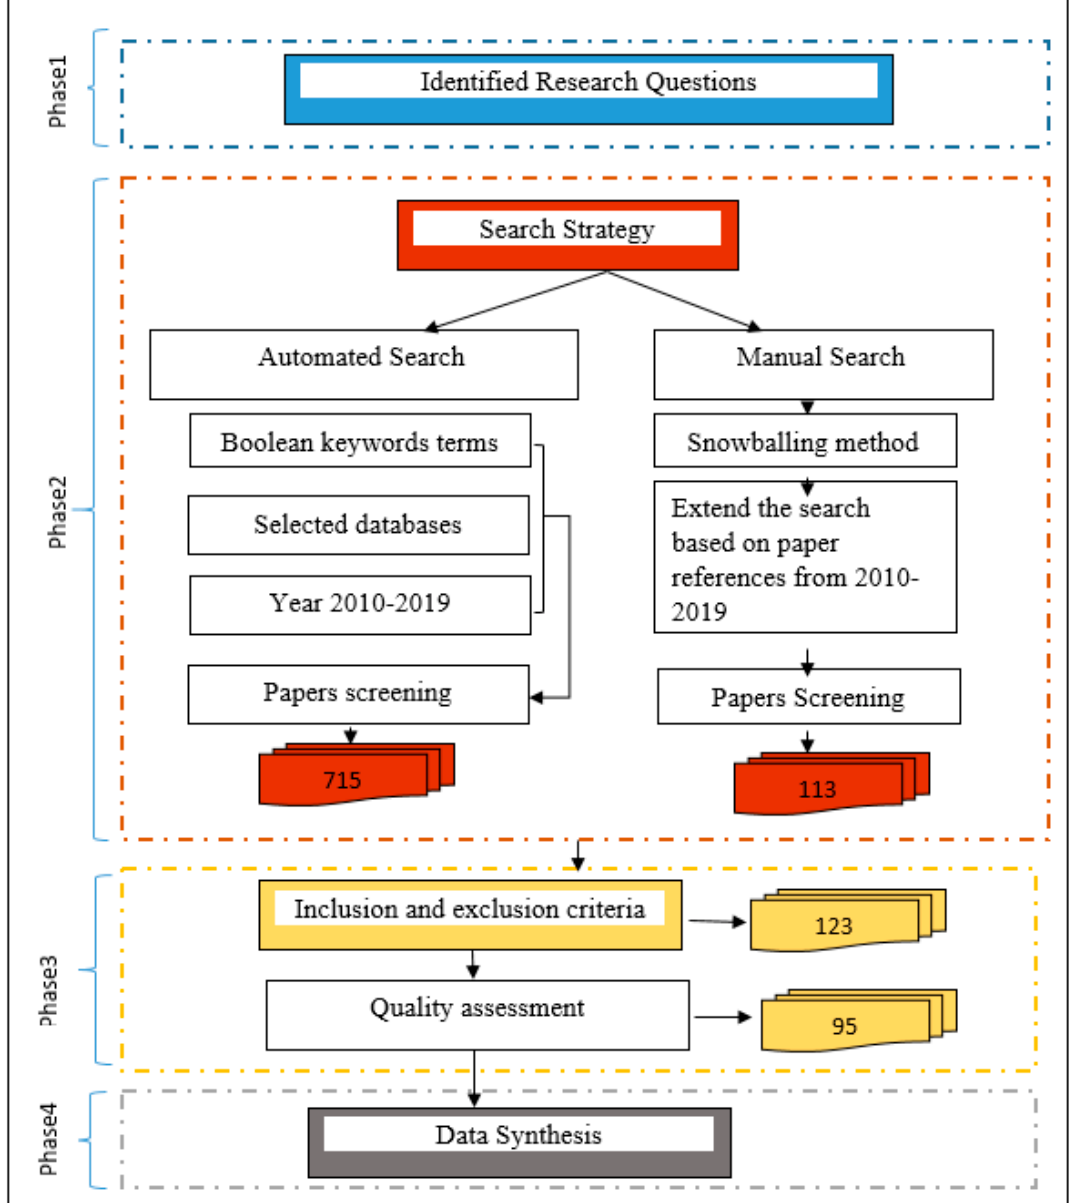
Figure 1. Research Figure 1. Research method.